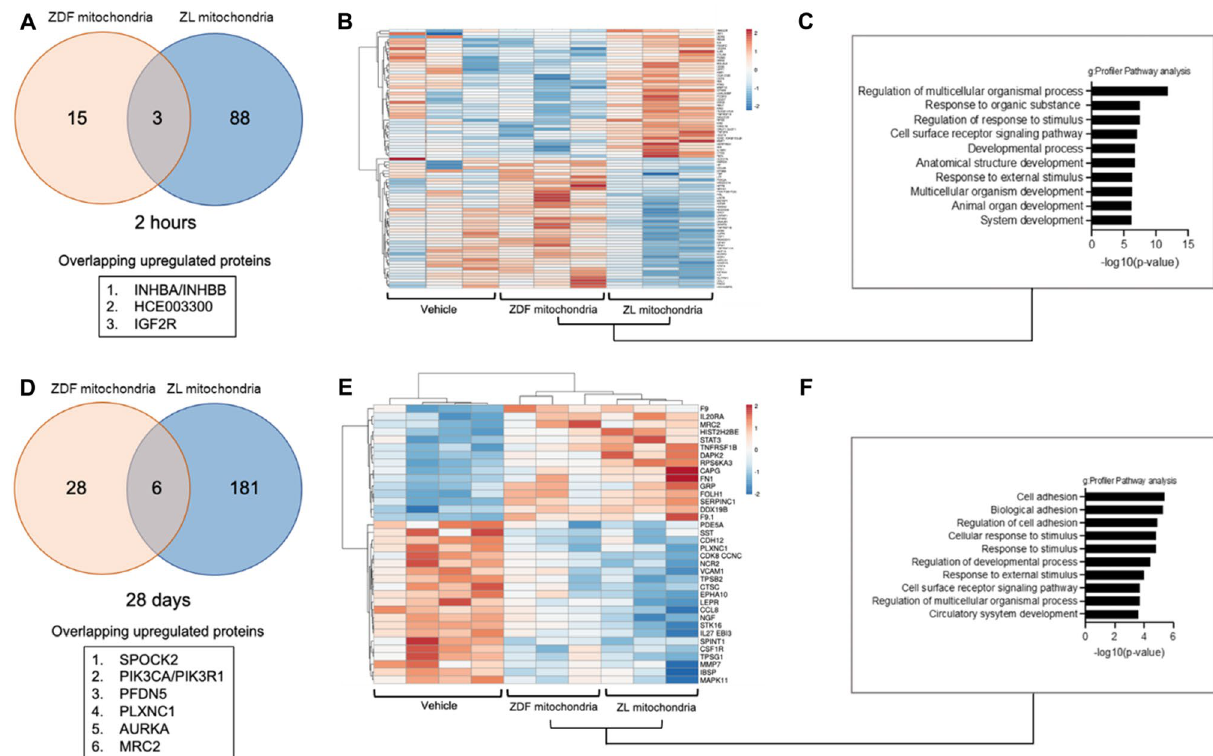
Figure 9. Non-diabetic ZL-mitochondrial transplantation induces a more robust proteomic response compared to ZDF mitochondria both at 2 h and 28 days. ( A ) Venn diagrams of upregulated proteins following 30 min IRI and 2 h recovery as compared to hearts receiving vehicle alone. Fold change is shown > 1.5; p < 0.05. ( B ) Heatmap of protein changes following 30 min IRI and 2 h recovery for hearts receiving diabetic ZDF- or non- diabetic ZL -mitochondrial transplantation as compared to hearts receiving vehicle alone. The log FC of protein levels is shown with pseudocolor scale (− 2 to 2), with blue denoting downregulation and orange denoting upregulation. Columns represent FC comparisons, and rows represent the proteins. Experimental groups are found on the bottom. ( C ) Top 10 enriched process networks following 30 min of IRI and 2 h recovery for hearts receiving diabetic ZDF- or non-diabetic ZL -mitochondrial transplantation as compared to hearts receiving vehicle alone. ( D ) Venn diagrams of upregulated proteins for hearts receiving diabetic ZDF- or non-diabetic ZL -mitochondrial transplantation as compared to hearts receiving vehicle alone following 30 min IRI and 28 days recovery (Fold change > 1.5; p < 0.05). ( E ) Heatmap of protein changes following 30 min IRI and 28 days recovery for hearts receiving diabetic ZDF- or non-diabetic ZL -mitochondrial transplantation as compared to hearts receiving vehicle alone. The log FC of protein levels is shown with pseudocolor scale (− 2 to 2), with blue denoting downregulation and orange denoting downregulation. Columns represent fold change comparisons, and rows represent the proteins. Experimental groups are found on the bottom. Fold change derived from comparison to Vehicle group. ( F ) Top 10 enriched process networks following 30 min IRI and 28 days recovery for hearts receiving diabetic ZDF- or non-diabetic ZL -mitochondrial transplantation as compared to hearts receiving vehicle